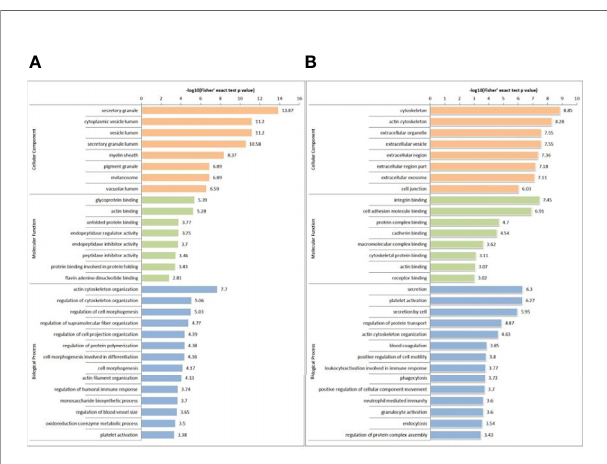
FIGURE 4 | GO-based enrichment analysis of DEPs (A) and DPPs (B) in terms of cellular component, molecular function and